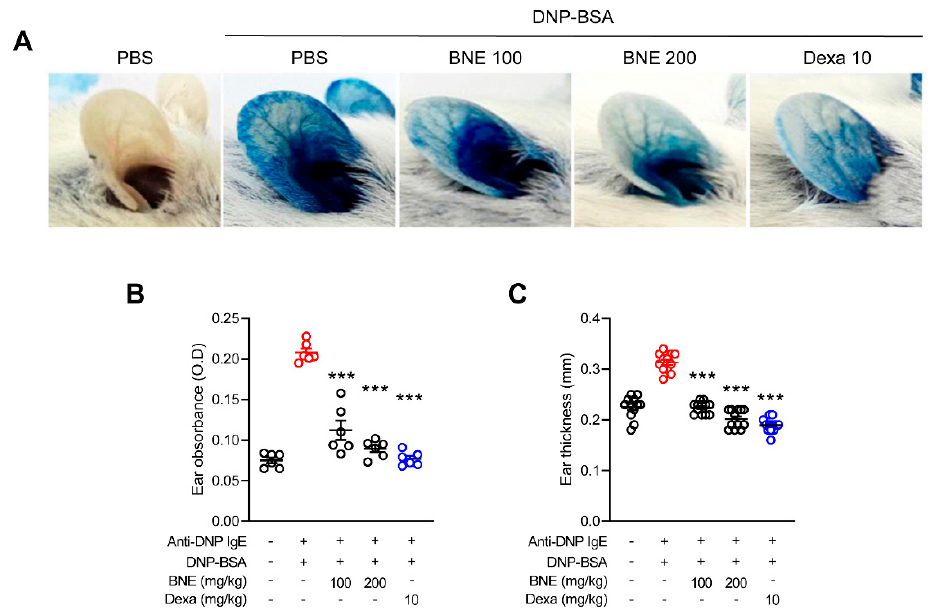
Figure 4. Effects of DNE on IgE-mediated passive cutaneous anaphylaxis. ( A ) The ear skin of mice ( n = 6/group) was sensitized by intradermal injection of anti-DNP IgE (0.5 mg/site) for 48 h. DNE (100 and 200 mg/kg) or dexamethasone (10 mg/kg) was orally administered before the intravenous (i.v.) injection of a DNP-BSA and 4% Evans blue (1:1) mixture. After 30 min, the thickness of both ears was measured. ( B ) Ear thickness was measured with a dial thickness gauge. ( C ) The dye was extracted and quantified using a spectrophotometer. Data represent the mean ± SEM from three independent experiments. * p < 0.05; ** p < 0.01; *** p < 0.001, Tukey’s test, significantly different from Anti-DNP IgE plus DNP-BSA with PBS-treated group. Anti-DNP IgE, anti-dinitrophenyl immunoglobulin E; DNP- BSA, dinitrophenyl-Bovine serum albumin; BNE, Boehmeria nivea extract; Dexa, dexamethasone.